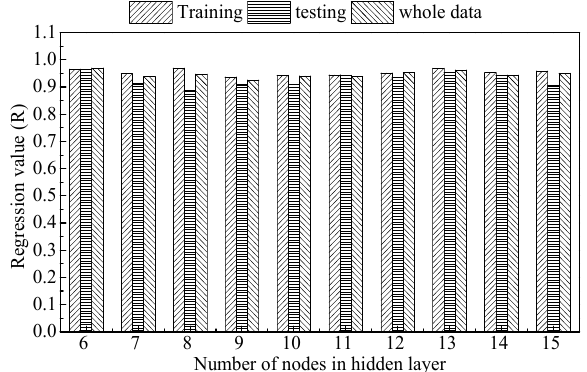
Figure 9. R-values of network with different numbers of notes in the hidden layer.